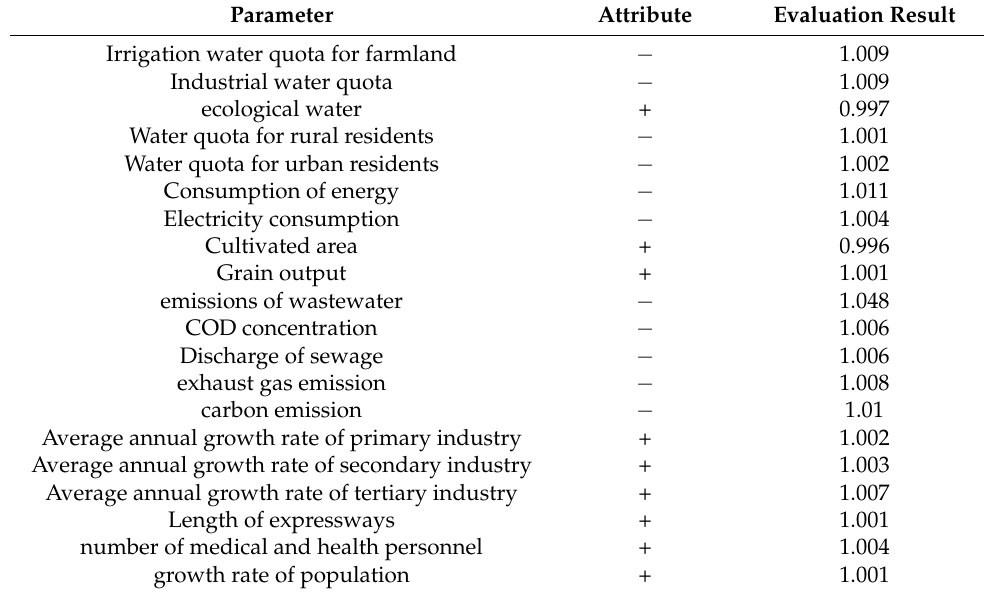
Table 5. Identification and analysis of key